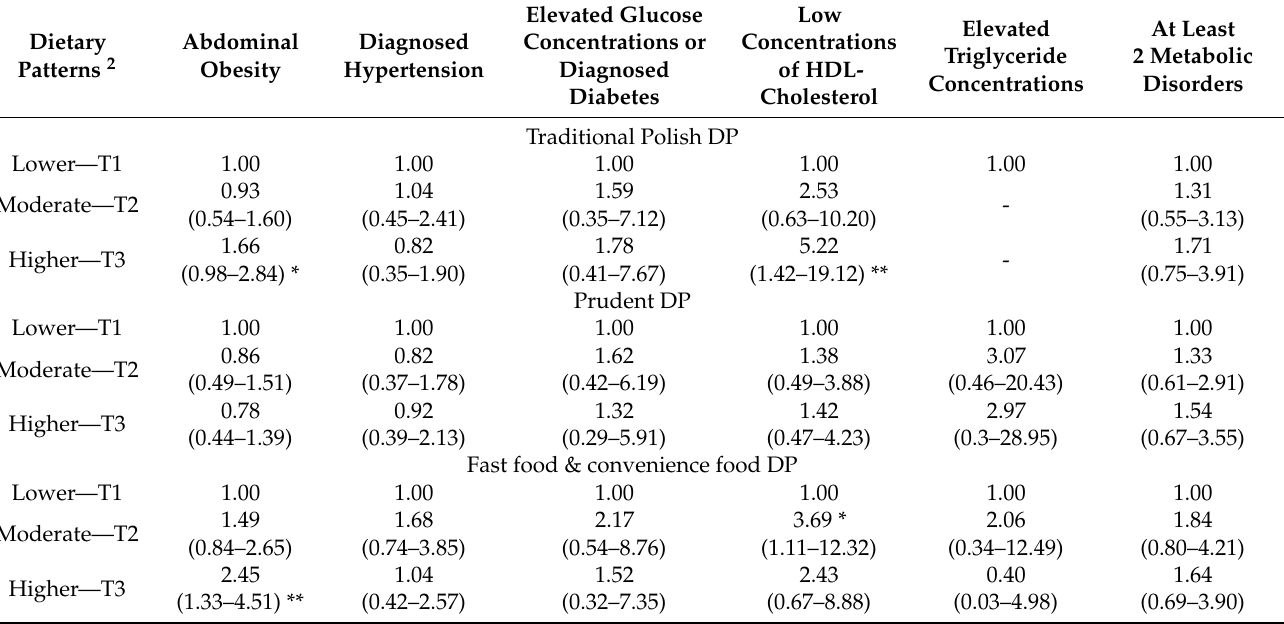
Table 7. Adjusted 1 associations between dietary patterns (DPs) and metabolic abnormalities ( n = 330): odds ratios (95% Confidence